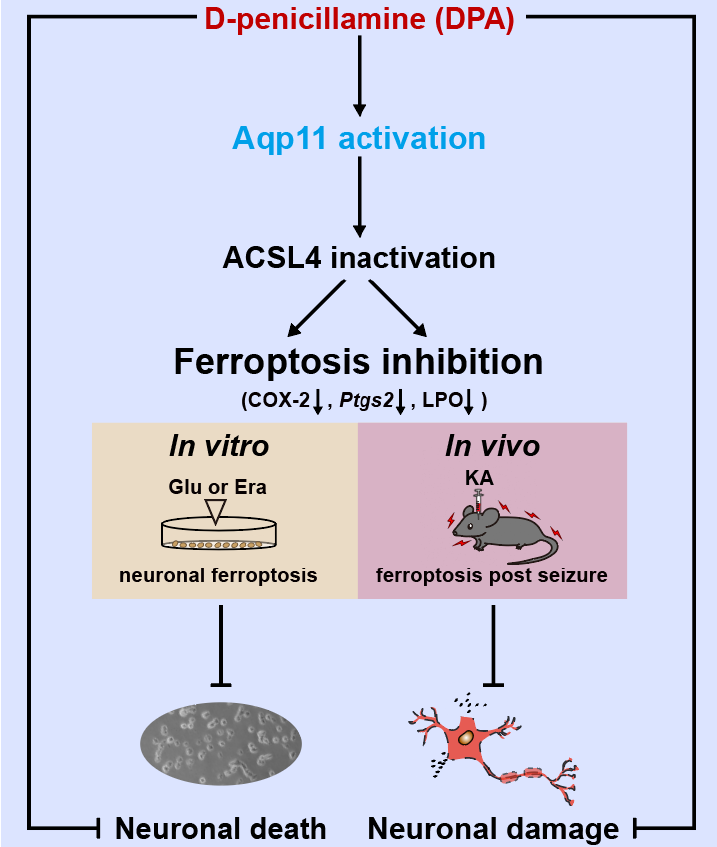
Figure 7. Schematic diagram illustrating DPA alleviates ferroptosis process and abrogates seizure- induced neuronal damage via activation of Aqp11 . Abbreviation: ACSL4, acyl-coA synthetase long chain family member 4; COX-2, cyclooxygenase-2; Ptgs2 , prostaglandin-endoperoxide synthase 2; LPO, lipid peroxide; Glu, glutamate; Era, erastin; KA, kainic acid.